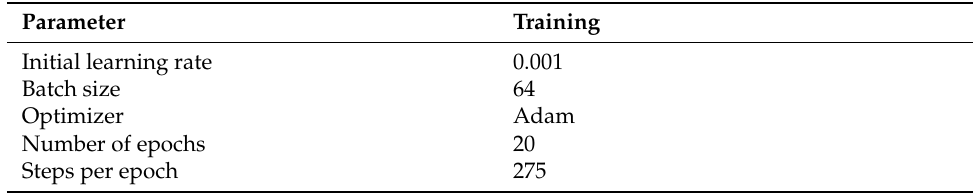
Table 1. Hyperparameters used for